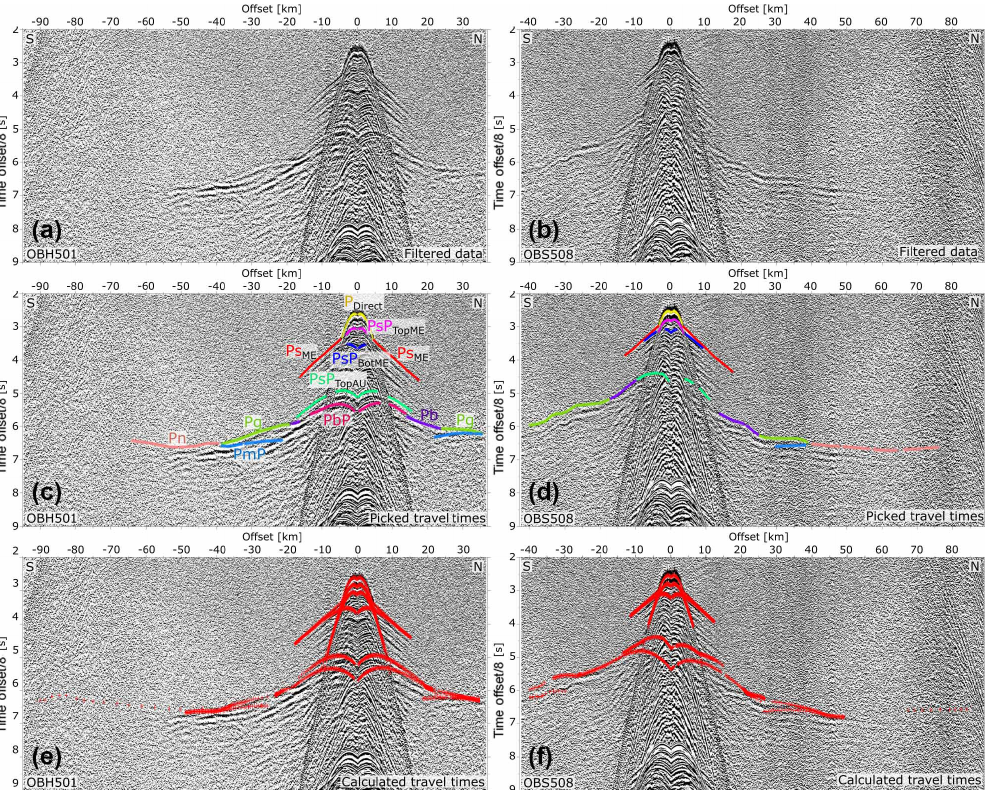
Figure 3. Seismic record sections of OBH501 and OBS508. Panels (a) and (b) show processed data. Panels (c) and (d) show the travel-time picks used for the forward modelling (please refer to phase definitions in the text). Calculated travel times from the final model are displayed in (e) and (f) . Data are plotted with a reduced time of 8kms − 1